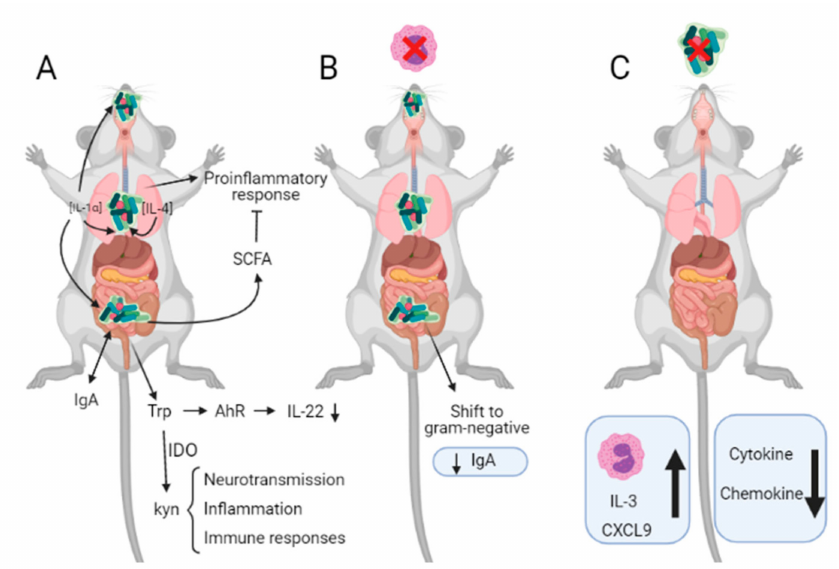
Figure 4. Cross-signaling between eosinophils and microbiota. ( A ) Summary of some processes in which murine microbiota is involved. ( B ) Alterations observed in eosinophil-deficient mice. ( C ) Alterations observed in germ-free (GF)